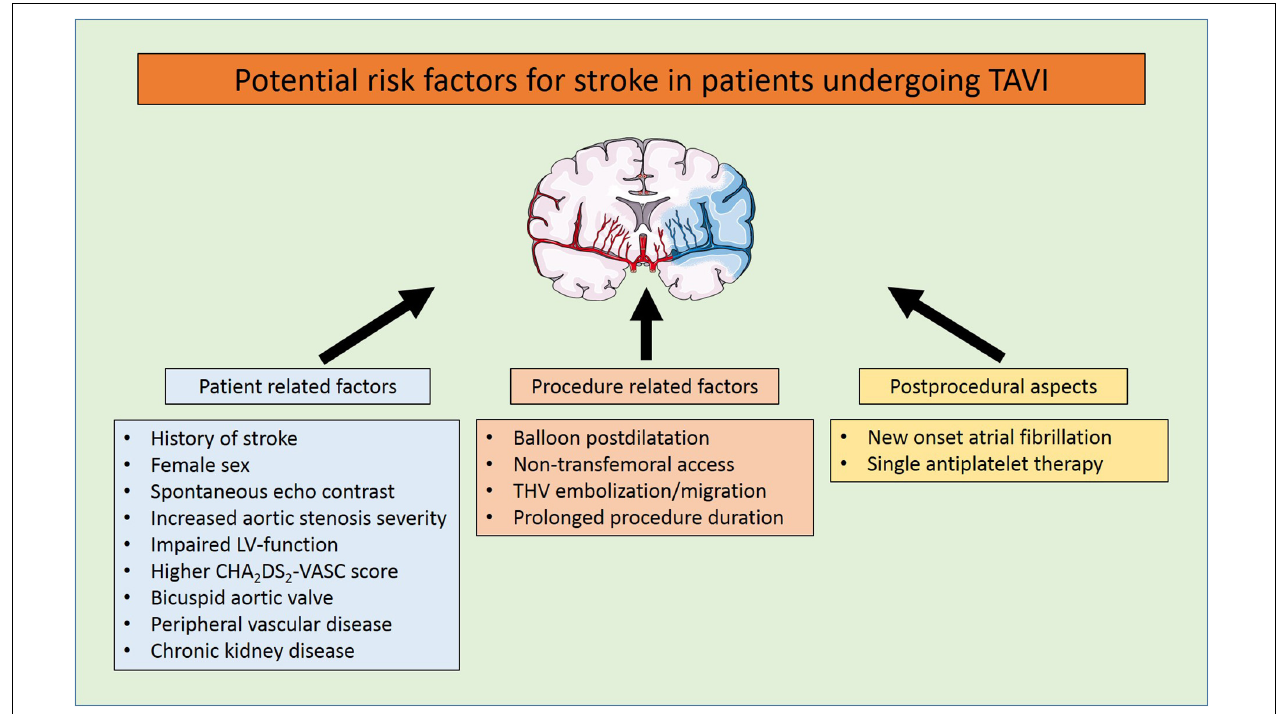
FIGURE 2 | Potential risk factors for stroke in patients undergoing